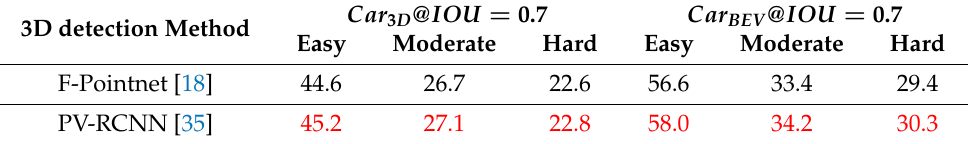
Table 10. Ablation study on LiDAR-based detector with the “car” category of the KITTI validation subset. 3D detection Method